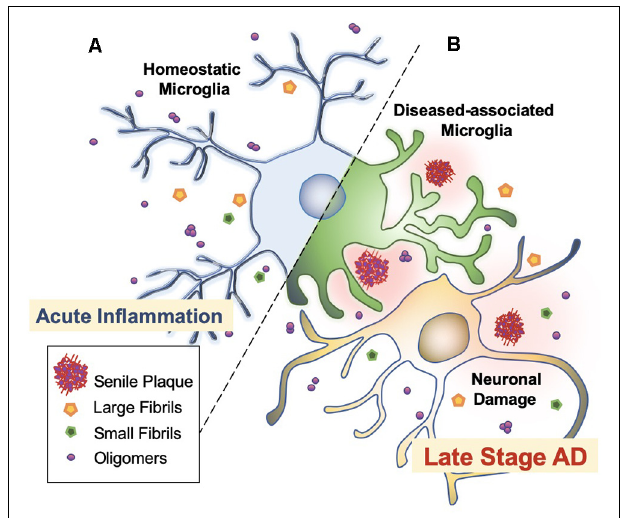
FIGURE 3 | Microglial activation checkpoints. (A) Homeostatic microglia. Resting microglia, under non-inflammatory healthy conditions, have a small soma with processes extending into the microenvironment (Webers et al., 2020). Triggering of PAMP or DAMP signals may occur intermittently, in which ramified microglia exhibit “controlled phagocytosis,” a process by which cells engage in the clearance of damaged cells and debris as part of their scavenging role within the brain (Sole-Domenech et al., 2016; Webers et al., 2020). (B) Disease-associated microglia. Intermediate activation of microglia exhibits larger and elongated soma, where microglia become highly motile with enhanced phagocytic activity and release pro-inflammatory cytokines (O’Brien and Wong, 2011). Fully activated microglia are located nearby A β plaques. In AD transgenic mice, gene set enrichment analysis revealed significant involvement in phagocytotic pathways, endocytosis, and regulation of anti-inflammatory and immune response in DAM (Keren-Shaul et al.,